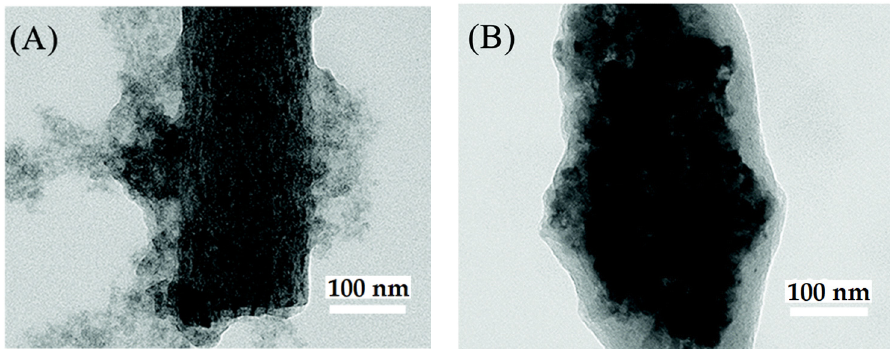
Figure 16. TEM images of ( A ) TiO 2 @GO and ( B ) TiO 2 @GO@C nanofiber membranes. (Adapted from the work of Zhang et al. [47]. Copyright 2020, with permission from Royal Society of Chemistry).